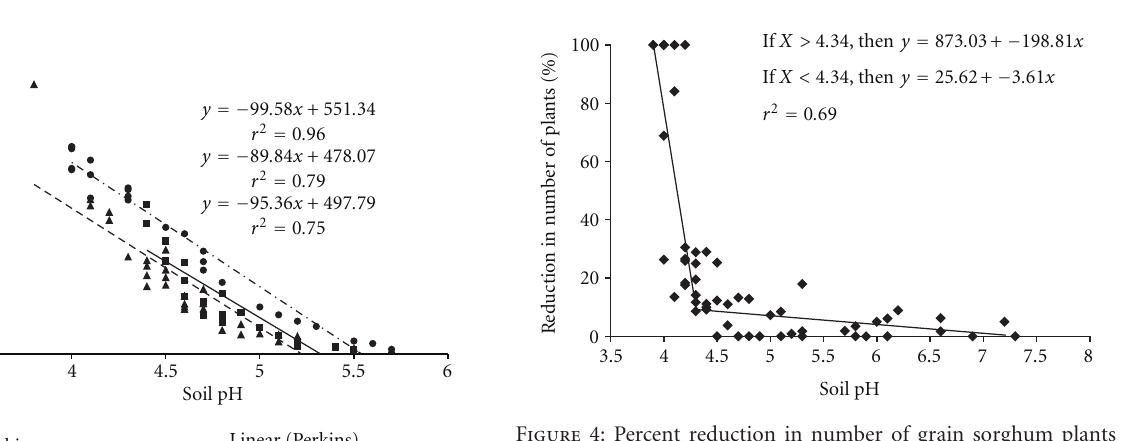
Figure 4: Percent reduction in number of grain sorghum plants from emergence to immediately prior to harvest at Perkins, Laho- ma, and Haskell, Oklahoma